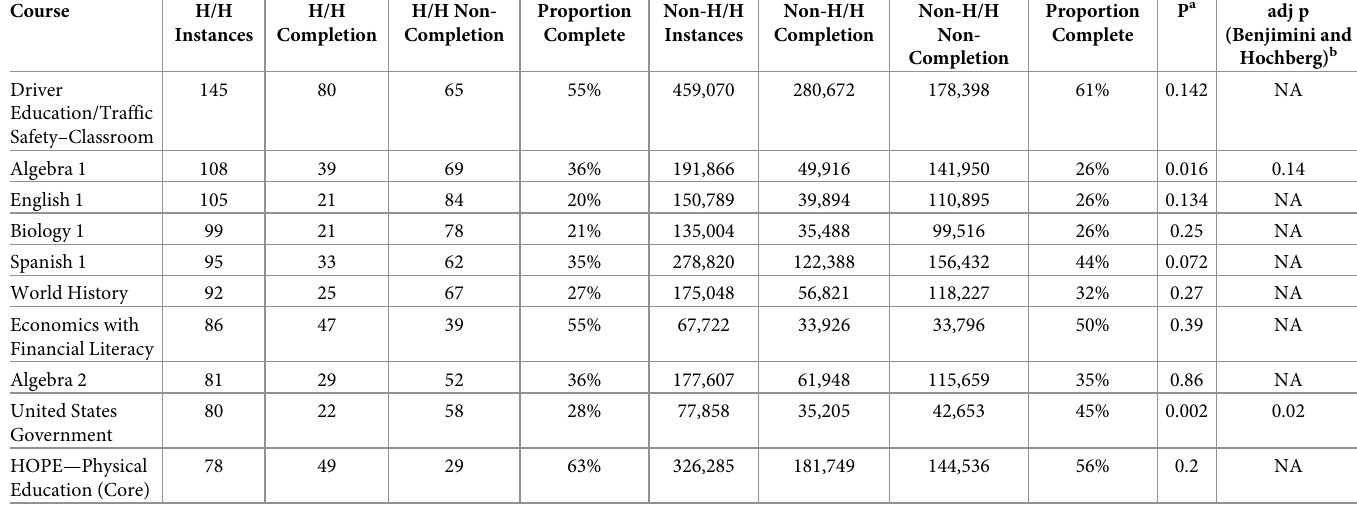
Table 3. Performance by course instance for the 10 most frequent course registrations by H/H students (with comparison to Non-H/H designated students) 2012– 2018.